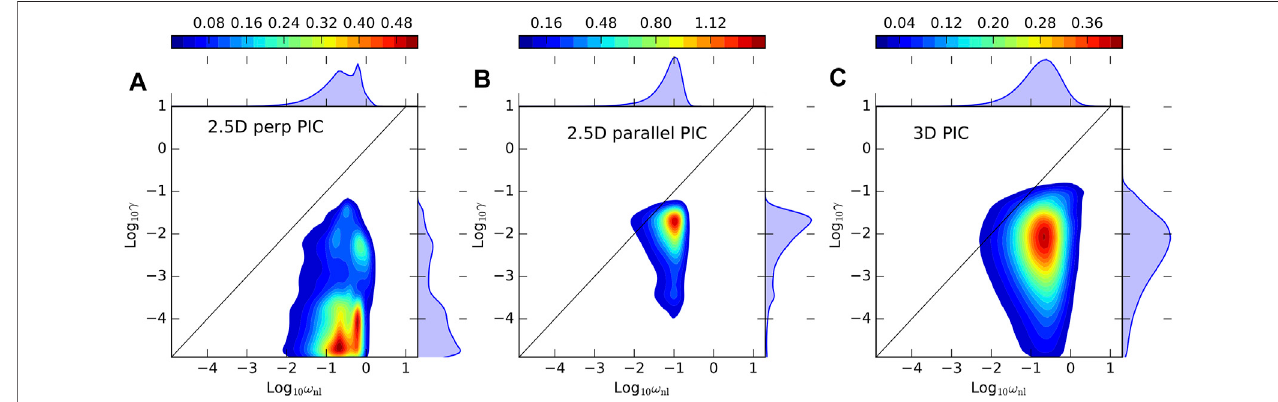
FIGURE6| Probabilitydistributionfunctions(PDFs)of t nl vs t inst. forthreefullykineticsimulations[104]. (A) 2.5DperpendicularPICwithmean fi eldoutoftheplaneof simulation, (B) 2.5DparallelPICwithmean fi eldintheplaneofsimulation,and (C) 3DPIC.The2.5DperpPICsimulationshowsadominanceofnonlineartimescales.The 2.5DparallelPICsimulationshowsadistributionwherenonlineartimescaledominatesstill.However,thedistributionliesclosetounity.3DPICshowsadistributionthatis similar to observations in the magnetosheath